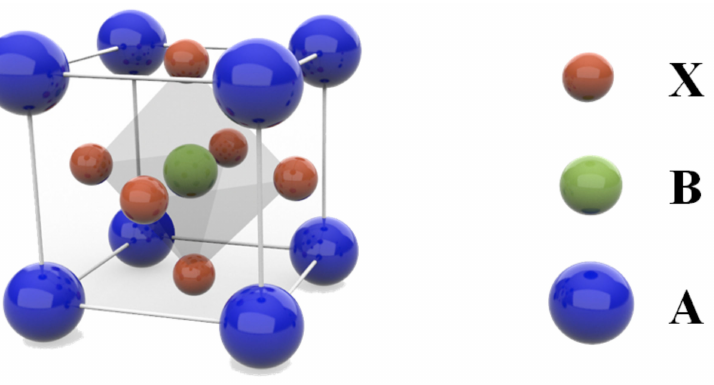
Figure 6. Crystal structure of perovskite absorption material ABX 3 (A: CH 3 NH 3 + , CH 2 (NH 2 ) 2 + , or Cs + ; B: Pb 2+ or Sn 2+ ; X: Cl − , Br − or I −